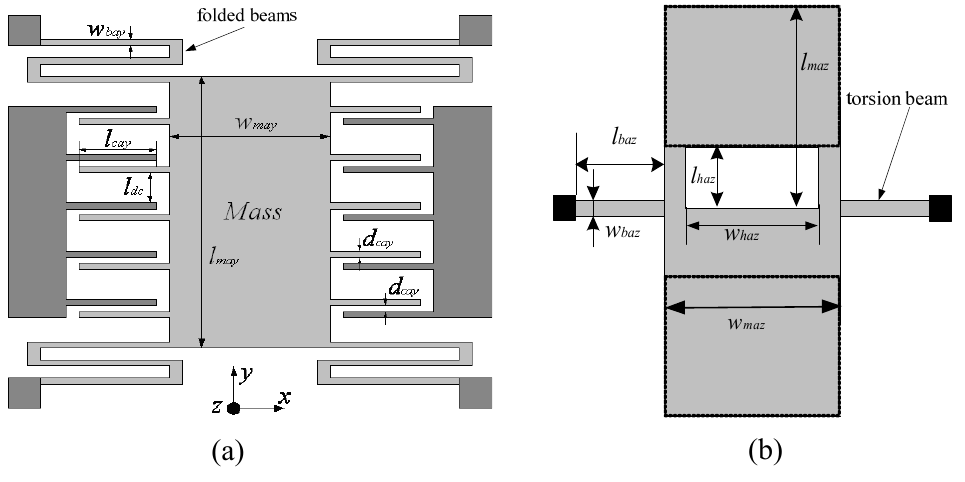
Figure 3. (a) The topology of the X/Y-axis accelerometer. (b) The topology of the Z-axis accelerometer.